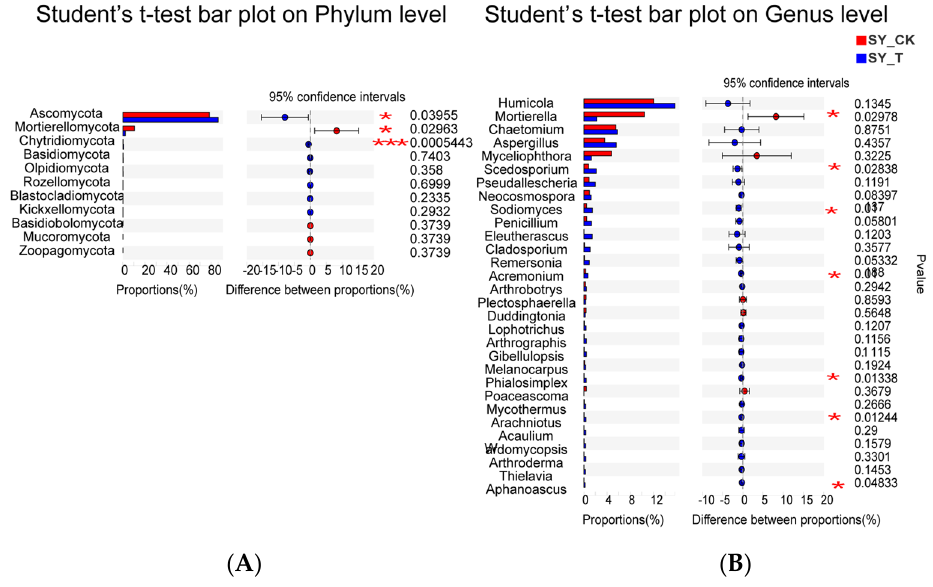
Figure 13. Changes in the relative abundance of fungal ( A ) phyla and ( B ) genera in triple-fumigated soil that had been used to produce cucumber. ‘Triple fumigation’ refers to the simultaneous appli- cation of chloropicrin, dimethyl disulfide and metham sodium. The t -test reported the statistical differences (asterisked, * 0.01 < p ≤ 0.05; *** p ≤ 0.001.) between the means of three replicates within the phylum or genus